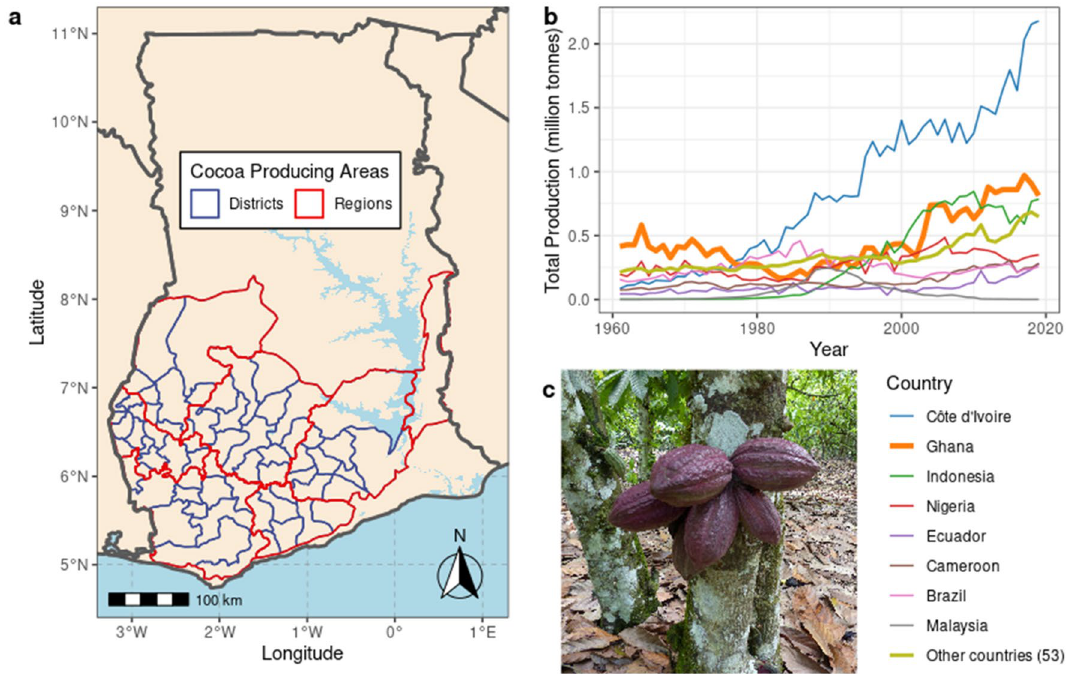
Figure 1. Cocoa production in Ghana. ( a ) Map of cocoa producing districts (blue outlines) and regions (red outlines) in Ghana. ( b ) Global cocoa production over the last 60 years. ( c ) Cocoa pods on a farm in Ghana (photo copyright